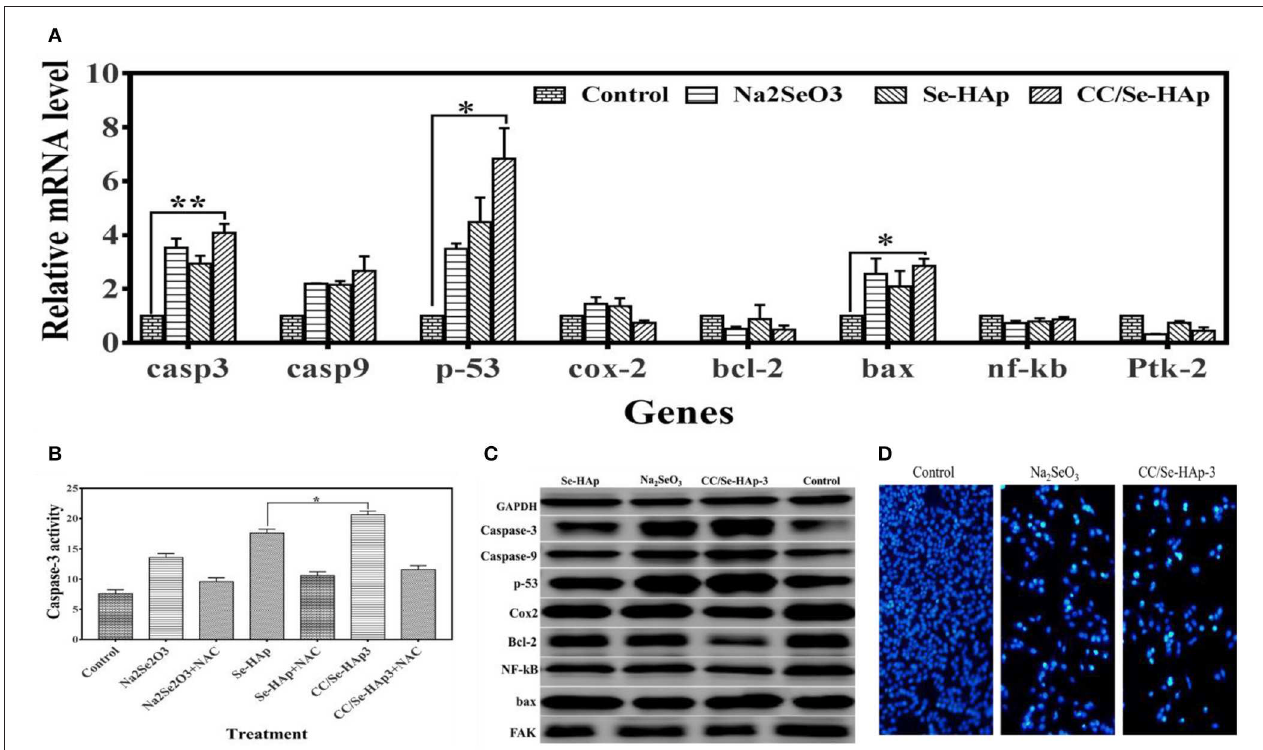
FIGURE 7 | Molecular analysis associated with apoptosis of MNNG/HOS cells treated with nanoparticles. (A) Expression levels of genes (analyzed through qPCR) associated with cancer and/or apoptosis were altered, which indicate their association with nanoparticles treatment. (B) The caspase-3 activity assay was evaluated by using the CaspACE Assay System. The increase in caspase-3 determines that CC/Se-HAp-mediated apoptosis is involved caspase-3 pathway. (C) Key proteins involved in apoptosis and cancer were analyzed using western blot in order to confirm the qPCR results. Western blot indicates the alteration in protein levels in response to treatment of nanoparticles. (D) The qualitative analysis of apoptosis using fluorescence cytometry confirms the effectiveness of nanoparticles. * p < 0.05 and ** p < 0.01 indicate significant differences in comparison with